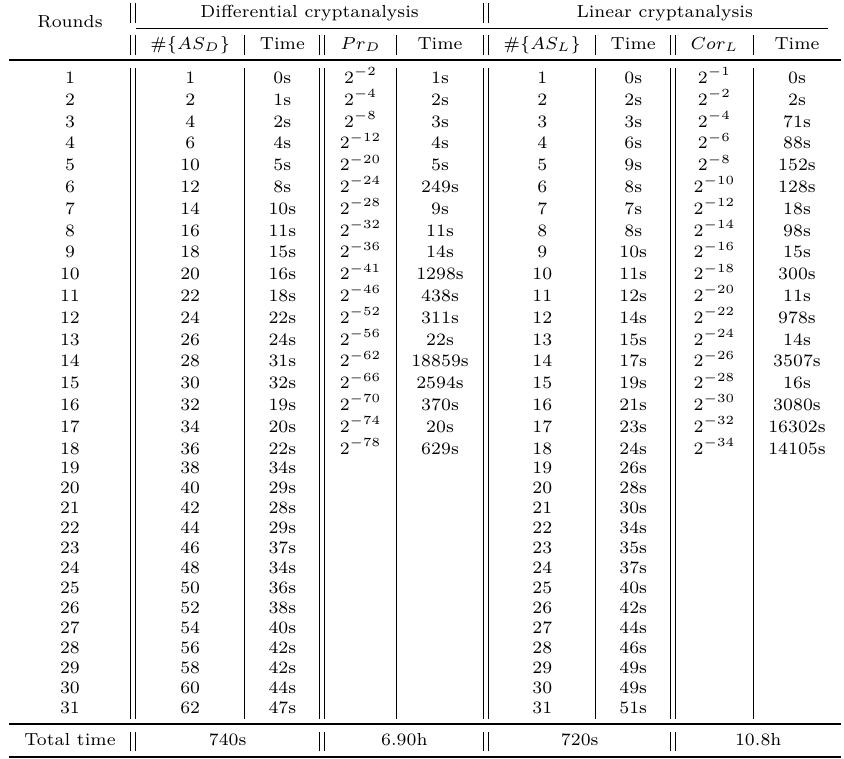
Table 2: Experimental results of PRESENT